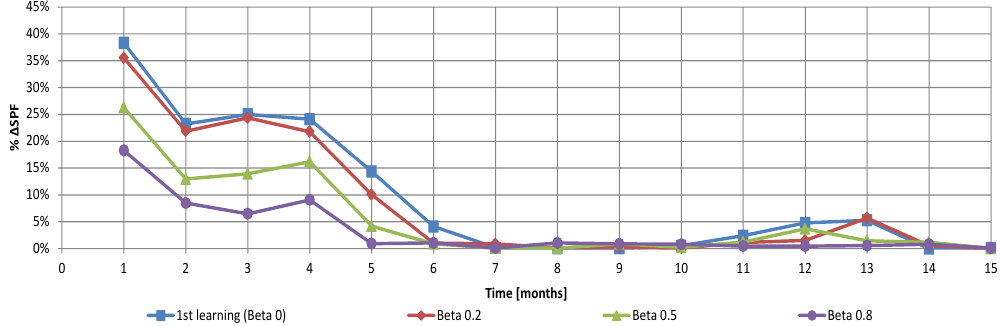
Figure 15. Monthly SPF coll relative errors (convergence values after five years) comparing the first learning and the second learning phase with different β values (0.2, 0.5, 0.8).